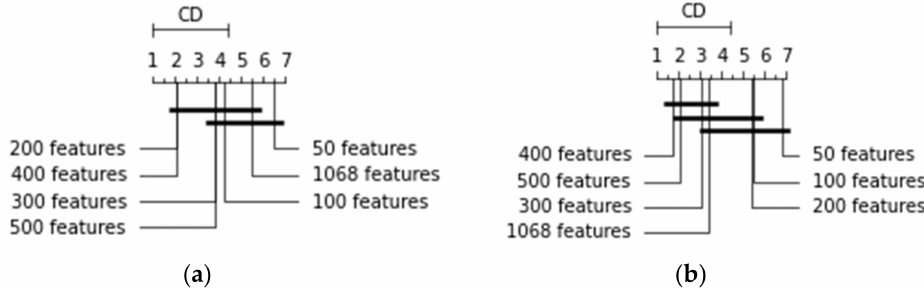
Figure 2. Demšar significance diagram for literary texts ( a ) and for social media texts ( b